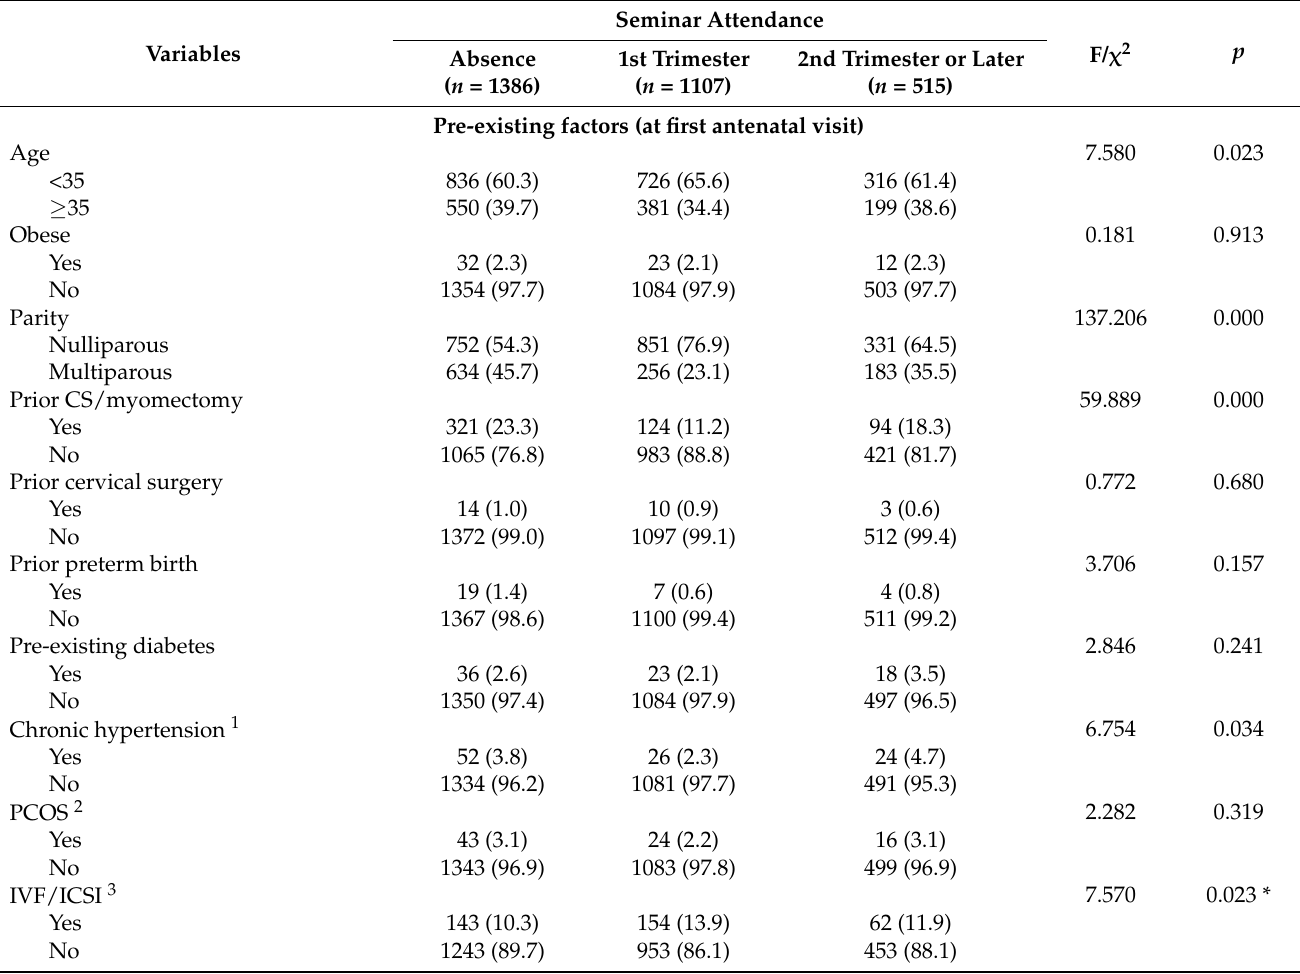
Table 1. Maternal characteristics and seminar